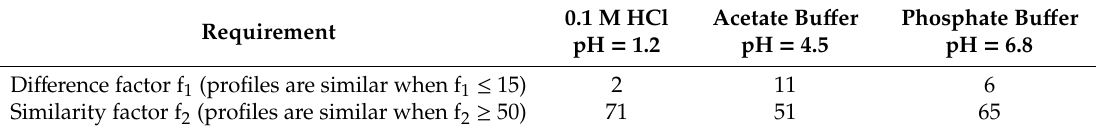
Table 6. Summary of f 1 and f 2 values for dissolution profiles curves in three di ff erent media. 0.1 M Requirement